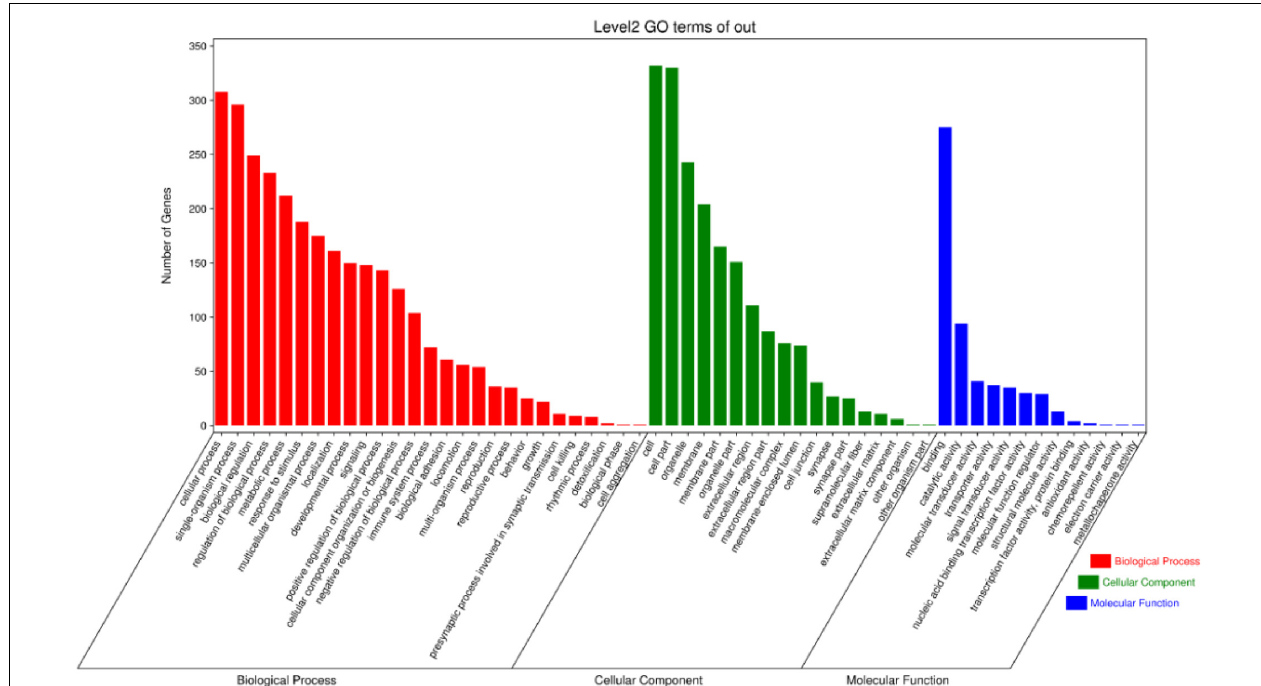
FIGURE 7 | GO classification of differentially expressed